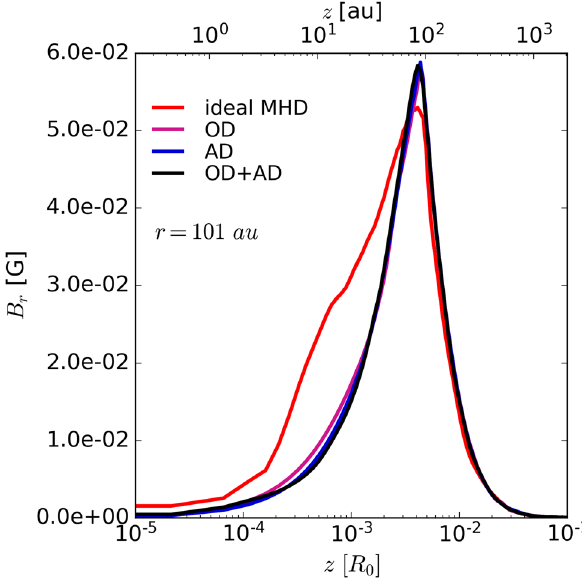
Figure 5: Vertical pro fi les of the radial component of the magnetic fi eld B r at100auinrunwith ε 0.3 t = , ε 0.2 m = ,and ε 0.01 w = .Di MHD e ff ects are considered: ideal MHD ( red line ) , Ohmic dissipation ( pink line ) , magnetic ambipolar di ff usion ( blue line ) and both types of di ff usion ( black line )